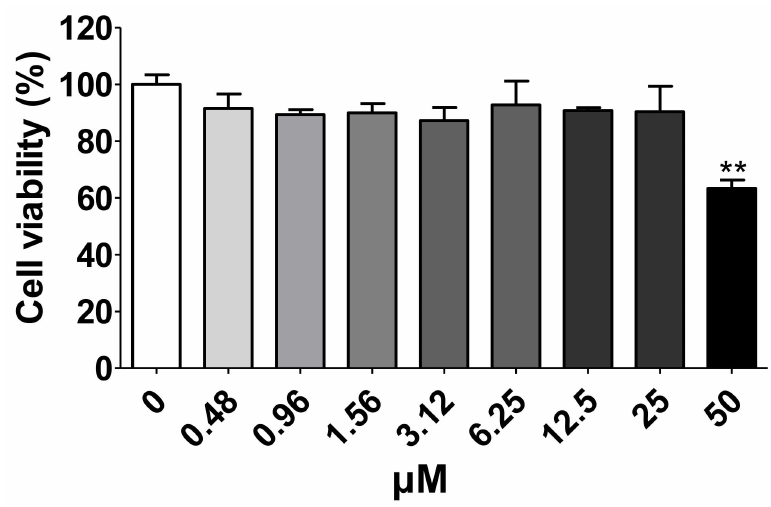
Figure 4. Determination of the cytotoxic effects of different concentrations of mulberrofuran G (MG) in HEK293T cells stably expressing human ACE2 and TMPRSS2. Cell viability after 24 h was determined by MTT (3-(4,5-dimethylthiazol-2-yl)-2,5 diphenyl tetrazolium bromide) assay. Bar graph (mean ± SEM) statistics were determined by three experimental datasets using one-way ANOVA with Tukey’s posthoc test; ** p < 0.01, compared with untreated sample (0 µ M MG).